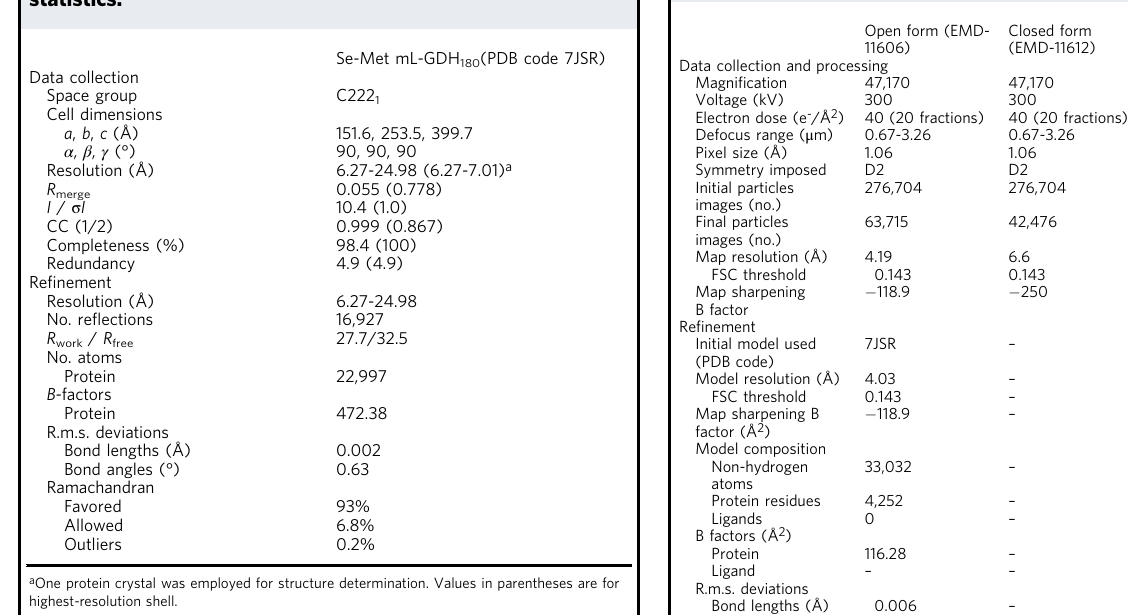
Table 2 Cryo-EM data collection and